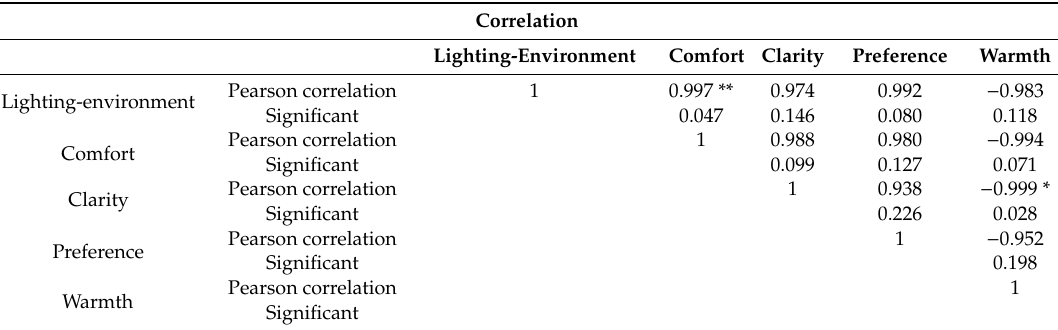
Table 6. Correlation between psychological perception and lighting